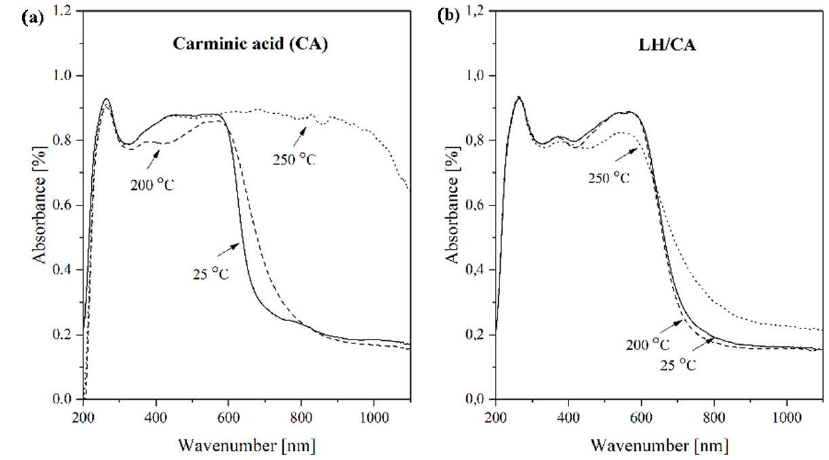
Figure 8. UV-Vis spectra of carminic acid and hybrid pigment exposed to different temperatures: ( a ) carminic acid and ( b ) LH/CA 20%.